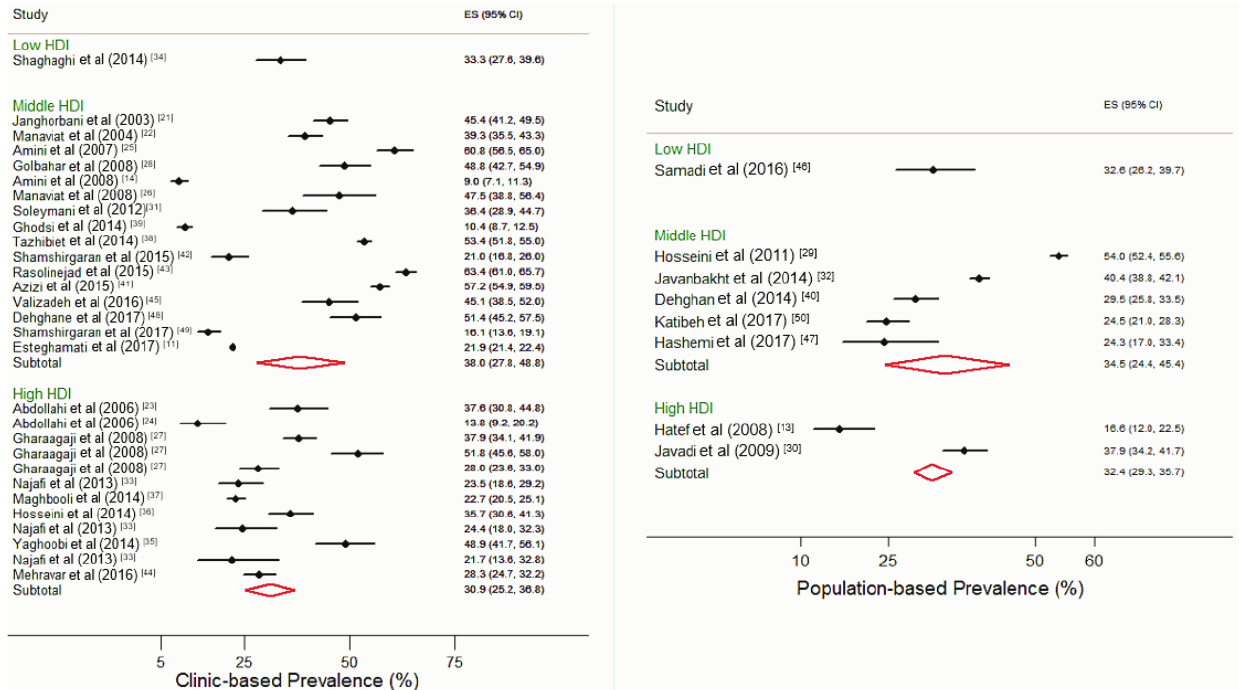
Figure 2. Forest plot of diabetic retinopathy prevalence by Human Development Index categories and source of data (clinic vs population-based studies). CI, confidence interval; ES, estimation of diabetic retinopathy prevalence (%); HDI, Human Development